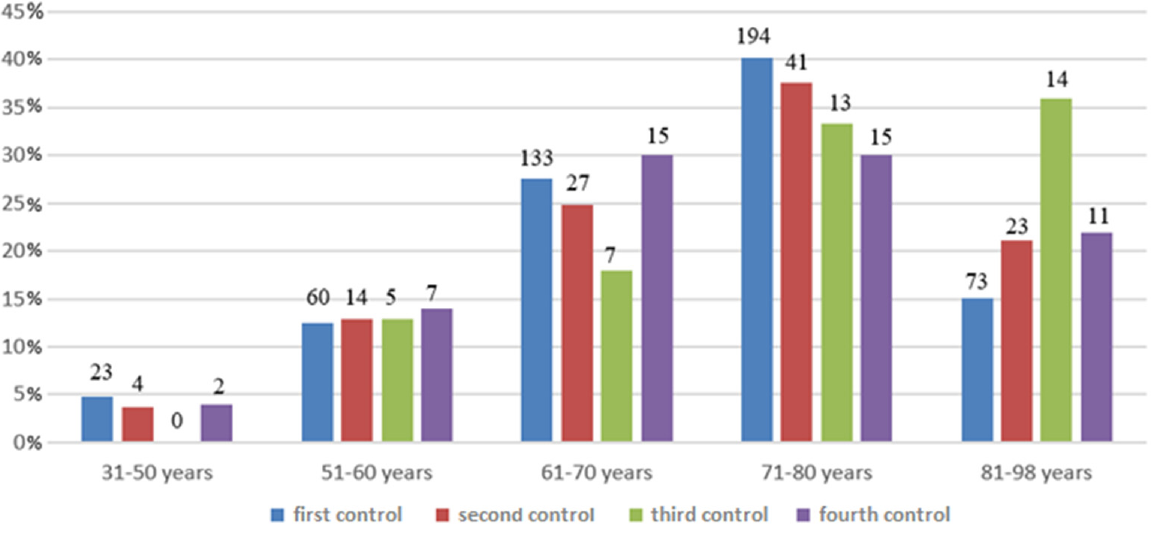
Figure 2. Sample divided for control and age.